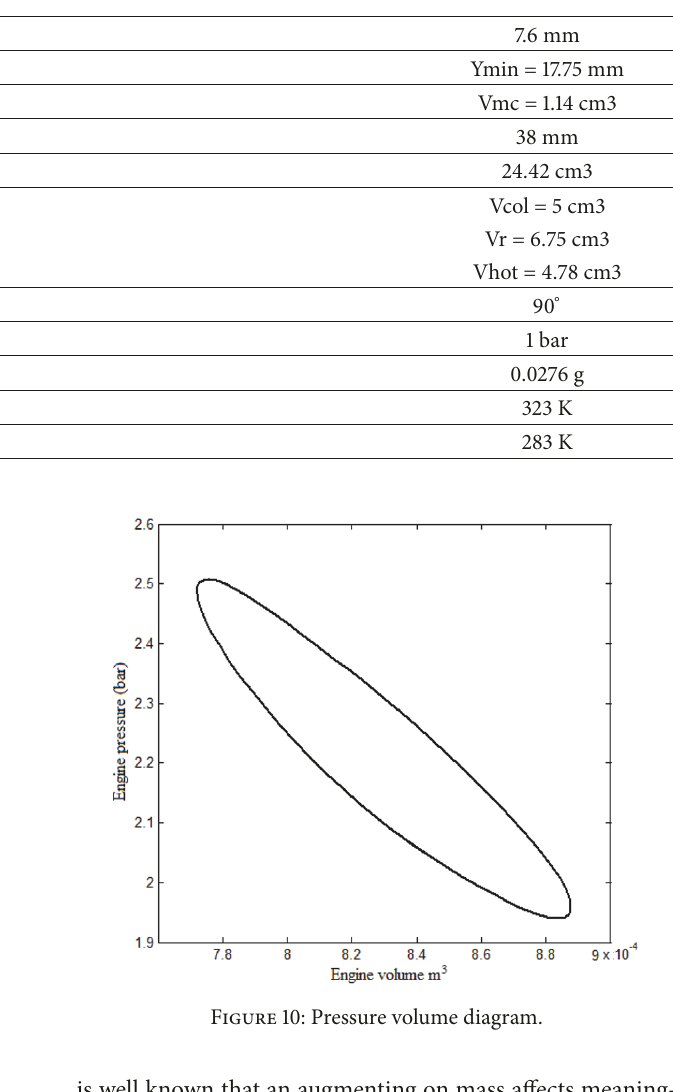
Table 6: Specifications of the Ross Yoke Stirling engine.